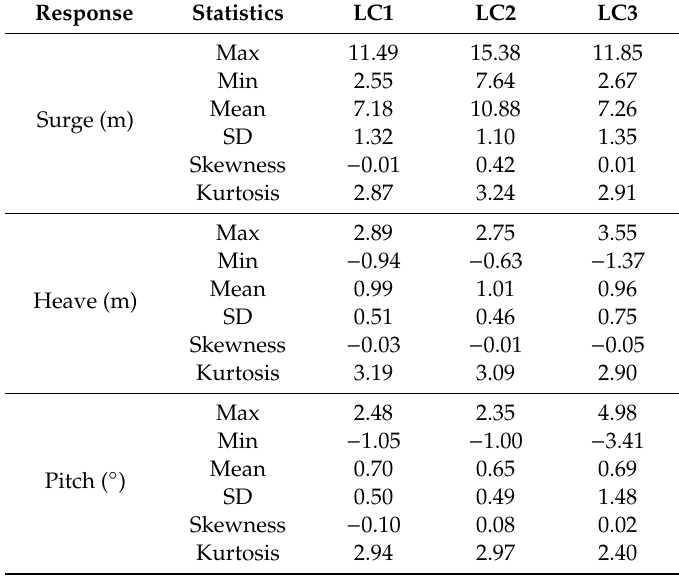
Table 8. Statistics of WSA